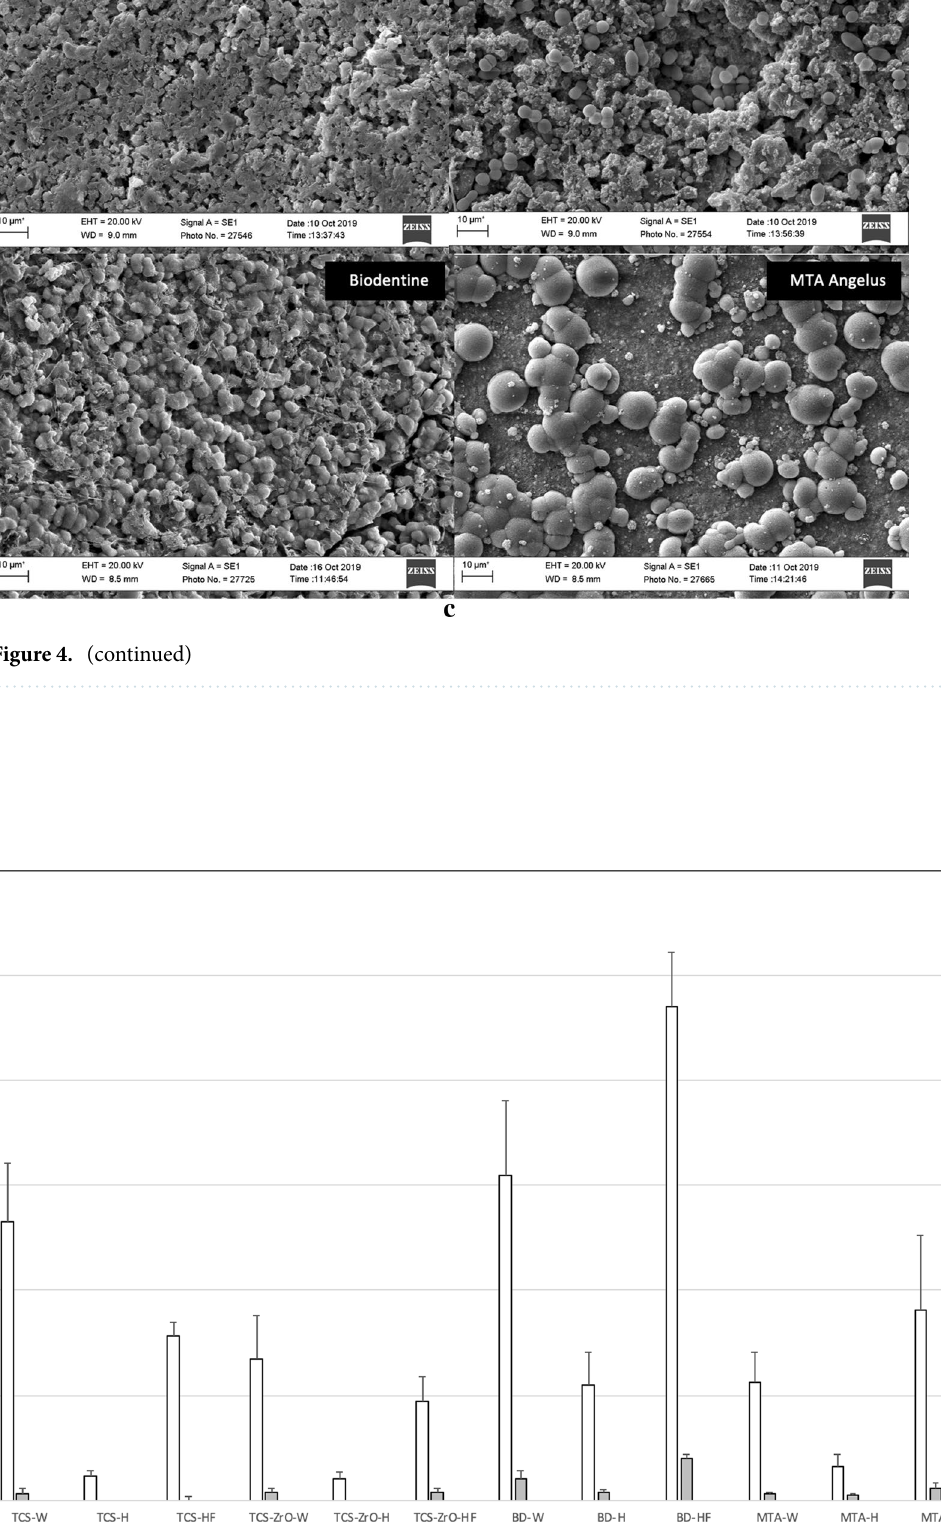
Figure 5. Elemental leaching in different solutions shown by the test materials showing a variation in the leaching of calcium and silicon observed by all materials while zirconium was